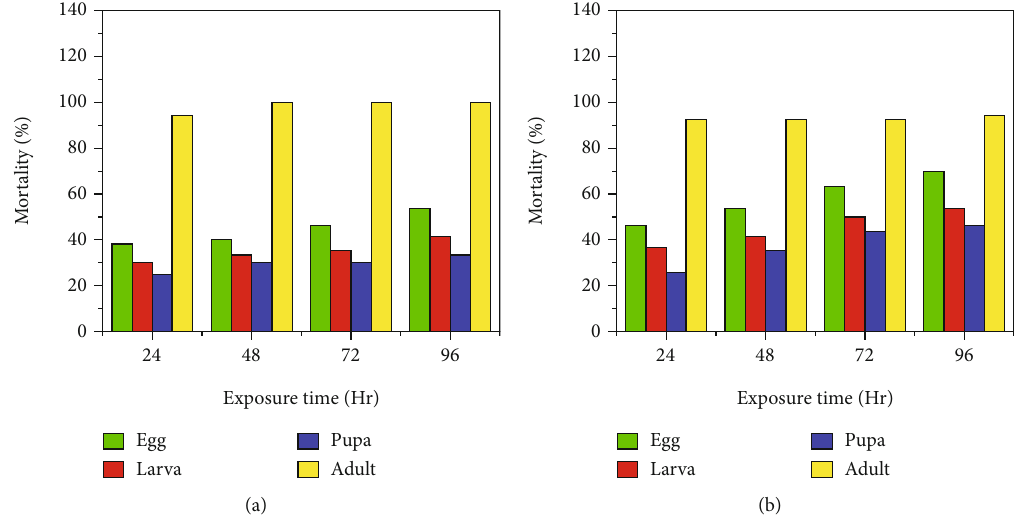
Figure 5: Mortality of Callosobruchus maculatus egg, larva, pupa, and adult at (a) 30% CO